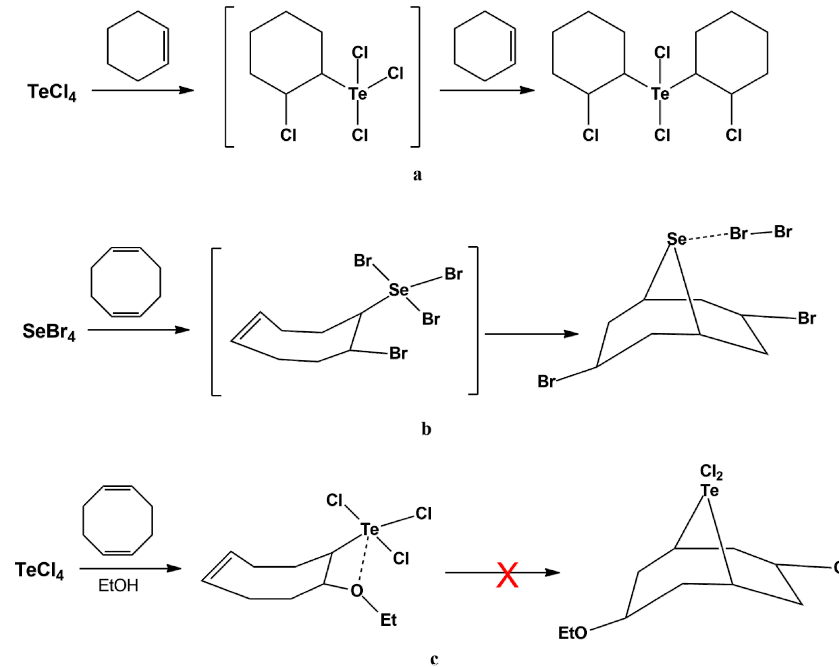
Scheme 2. Interaction of ( a ) cyclo-hexene with TeCl 4 ; cyclo-octa-1,5 diene with ( b ) SeBr 2 ; ( c ) TeCl 4.